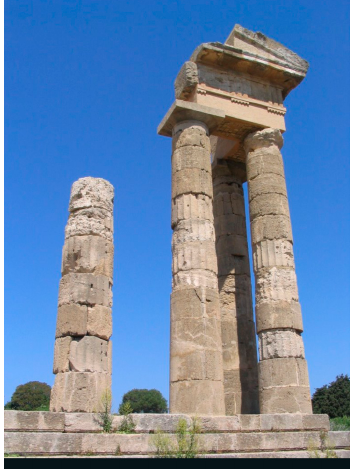
Figure 26. The Temple of Pythian Apollo in Rhodes before the scaffolding (2001). Appl. Sci. 2018 , 8 , x FOR PEER REVIEW